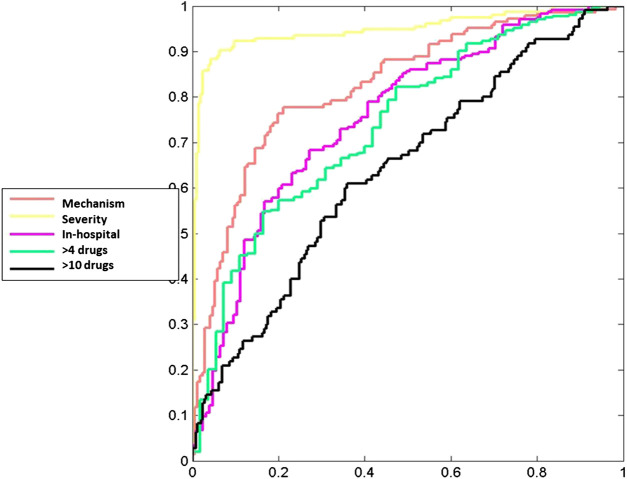
ROC curves for the dependent variables.